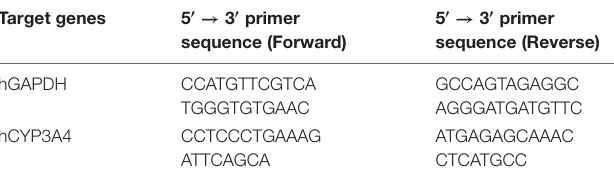
TABLE 1 | Sequences of primer pair used for PCR